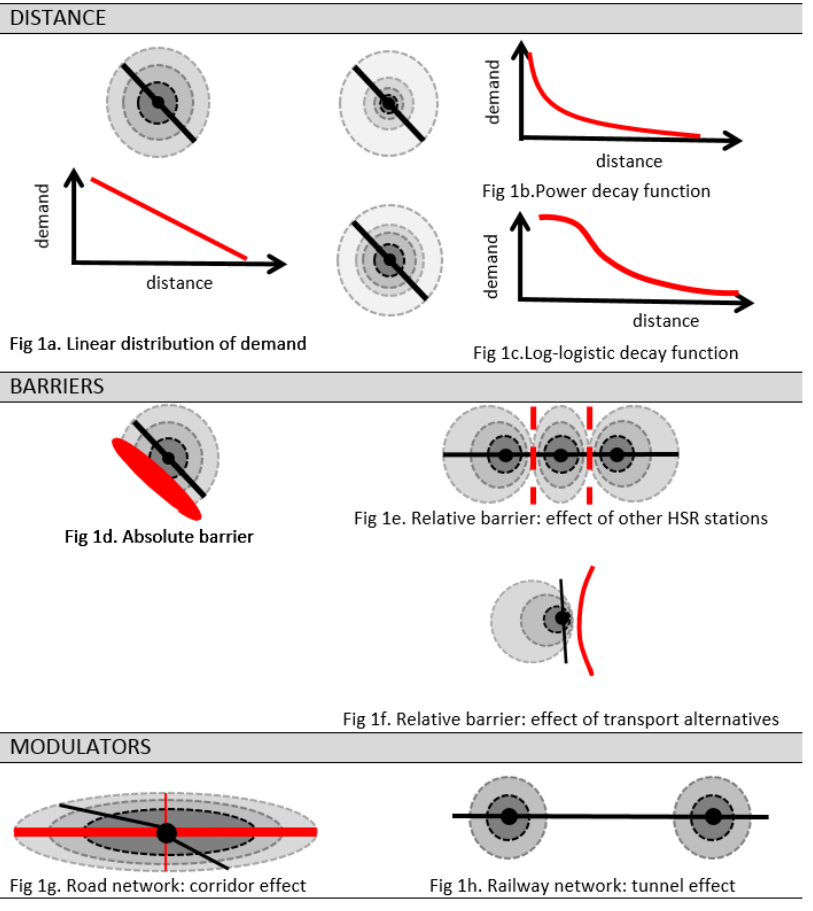
Figure 1. Spatial approach to the analysis of catchment areas. Source: own